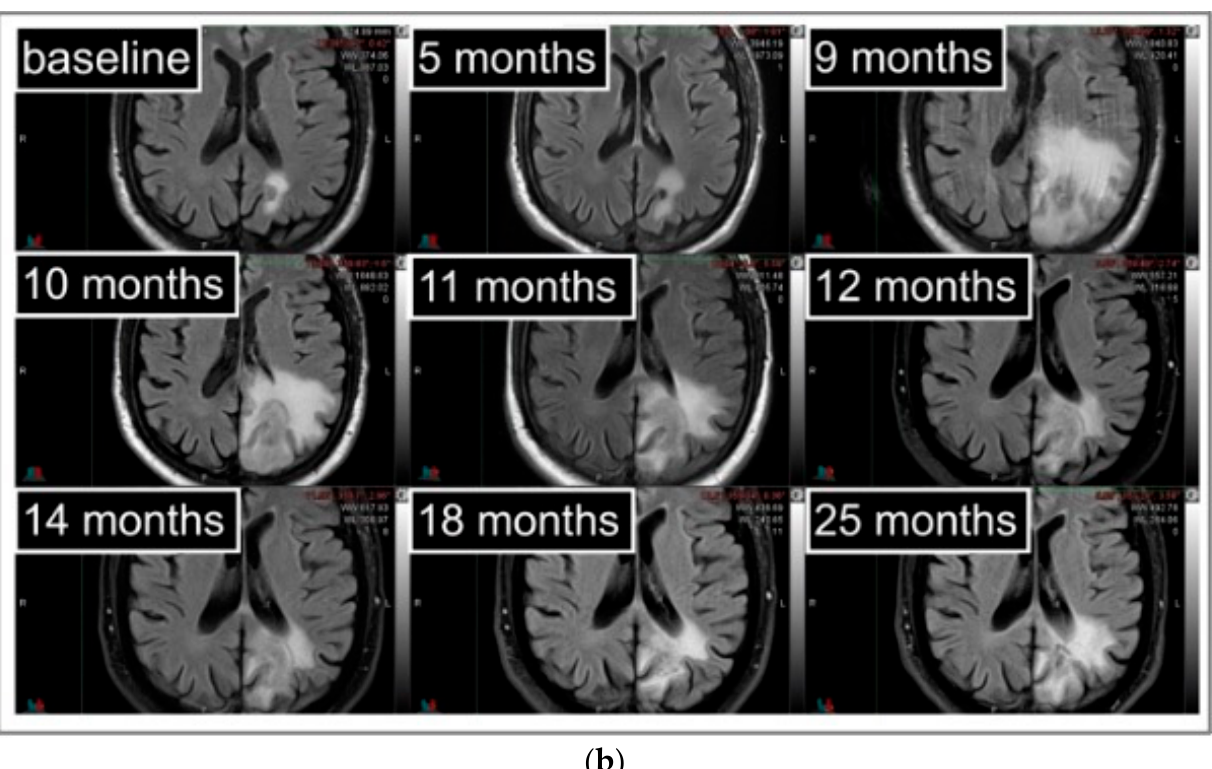
Figure 3. Serial axial gadolinium-enhanced T1-w ( a ) and T2-w ( b ) sequences in follow-up MRI images of a 74-year-old man. The brain metastasis was centrally located, infratentorial, at grey–white matter interface, in the left occipital lobe. Symptomatic RN arose during the 9th month. After 9 months of steroid dependence, clinical and radiological stabilization were obtained. The patient has now been steroid-free for 7 months and is in excellent general health. However, a close follow-up is still required.